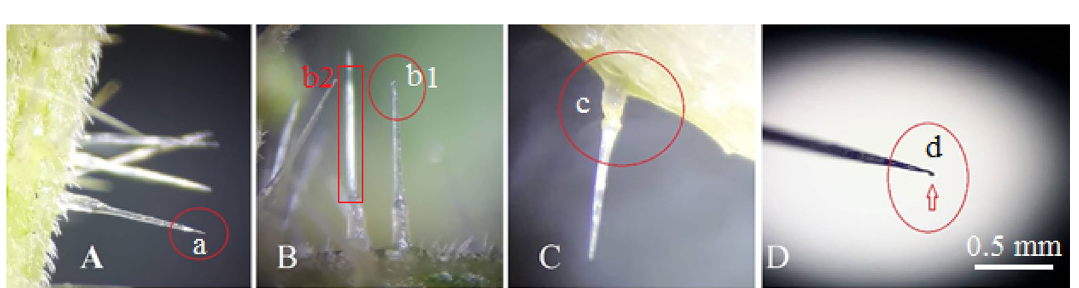
strong structure of needles ( E – G ) special ornaments at the beginning of the crack ( E ). A faint liquid seen on the surface of the Styrofoam ( H ). The surface of the nanofabric before the bite ( I ) and the same fabric after the bite ( J – L ) are shown.